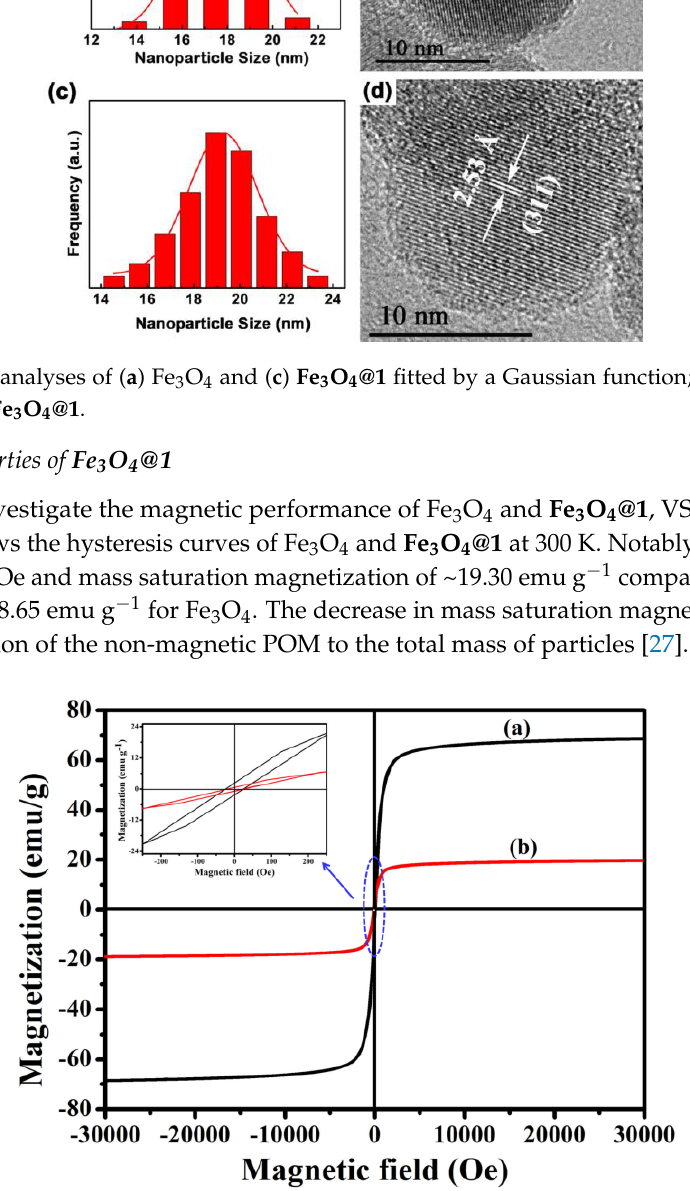
Figure 7. Magnetic measurements of ( a ) Fe 3 O 4 and ( b ) Fe 3 O 4 @1.